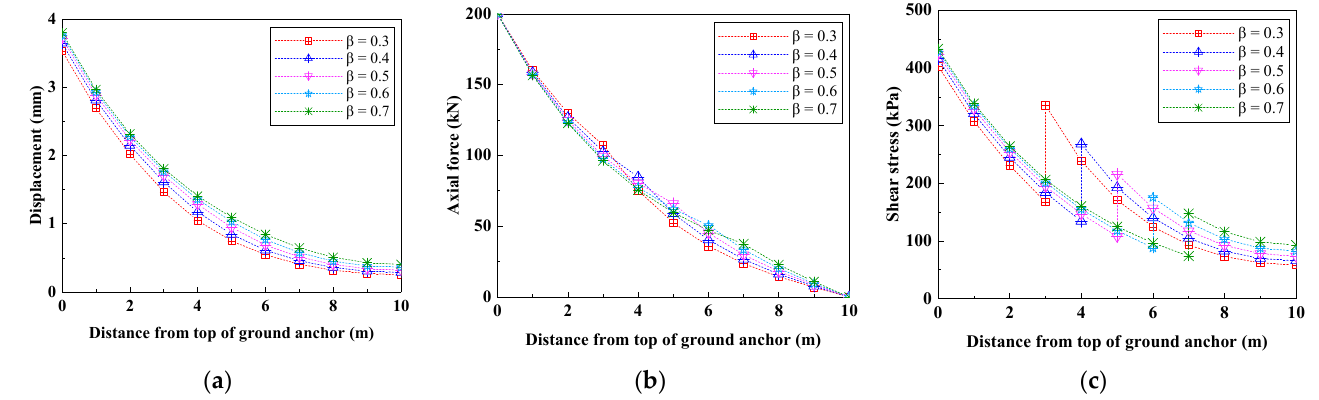
Figure 7. Effect of the depth of stratum interface on mechanical behavior of ground anchor. (Case 1: condition 2) ( a ) displacement distribution curve; ( b ) axial force distribution curve; ( c ) shear stress distribution curve.